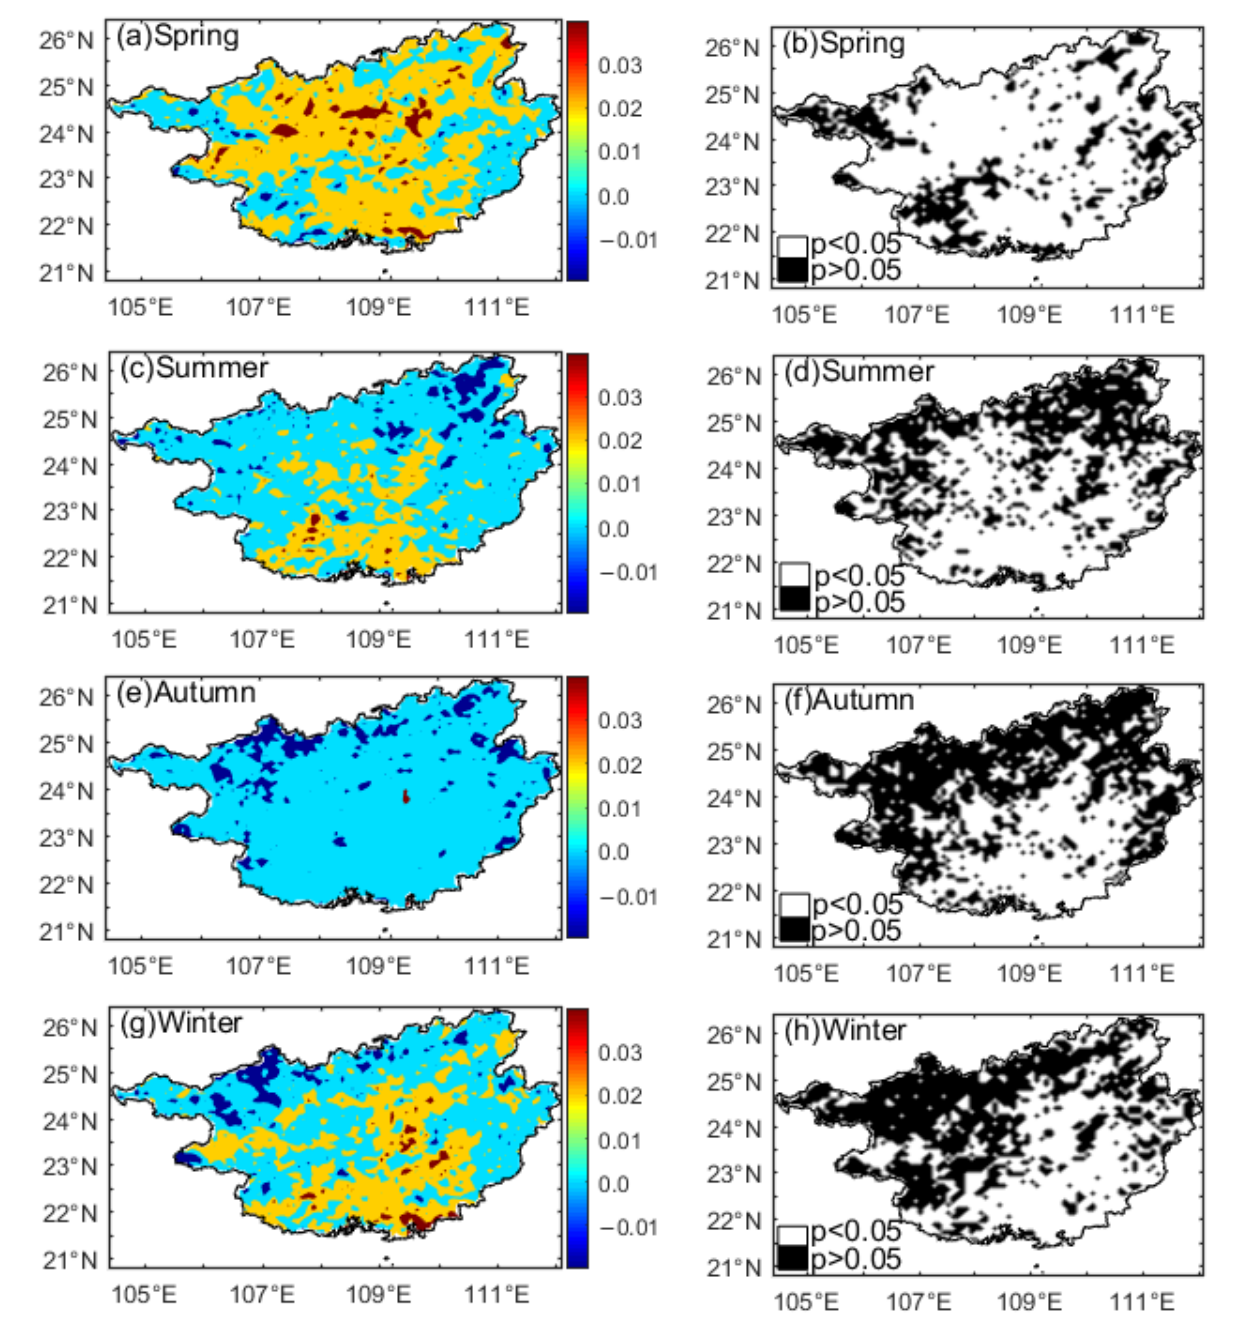
Figure 5. Spatial distributions of the trend rates of the seasonal NDVI (unit: 10 × year − 1 ) ( a , c , e , g ) and their significant test ( b , d , f , h ) during 1982–2015.